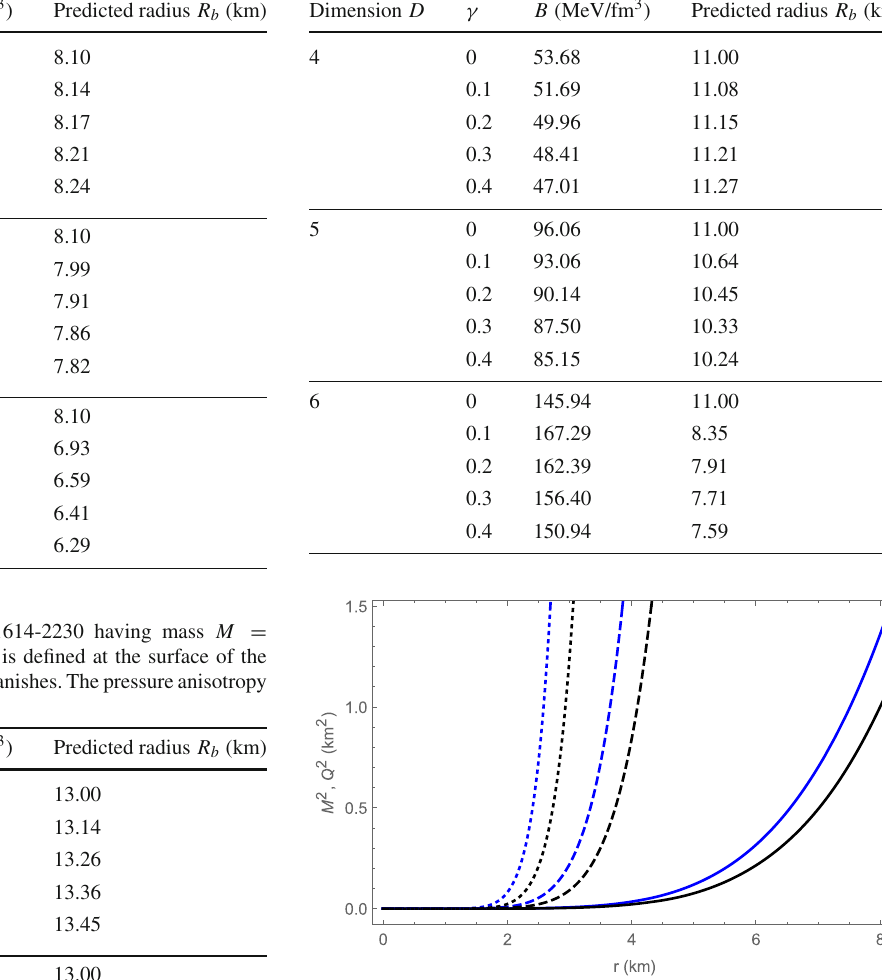
Table 7 Predicted radius of EXO1745-248 having mass M = 1.4 M (cid:2) . Here the bag parameter ( B ) is defined at the surface of the compact object where radial pressure vanishes. The pressure anisotropy param- eter ( α ) is taken as unity